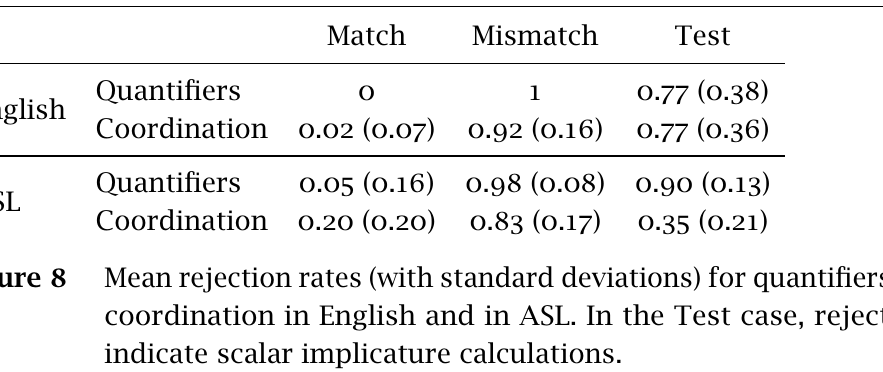
Mean rejection rates (with standard deviations) for quantifiers and coordination in English and in ASL. In the Test case, rejections indicate scalar implicature